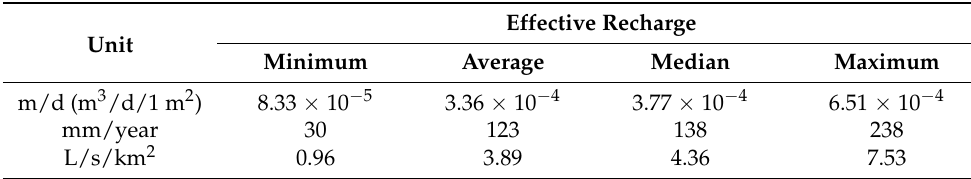
Table 2. Variation in effective recharge, after model calibration.